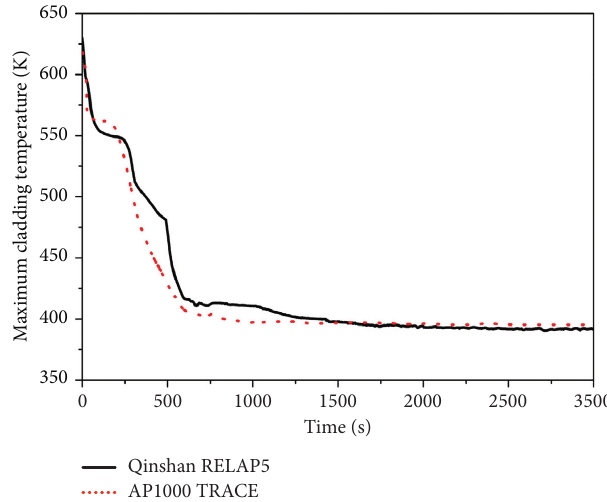
Figure 26: DEDVI line break maximum cladding